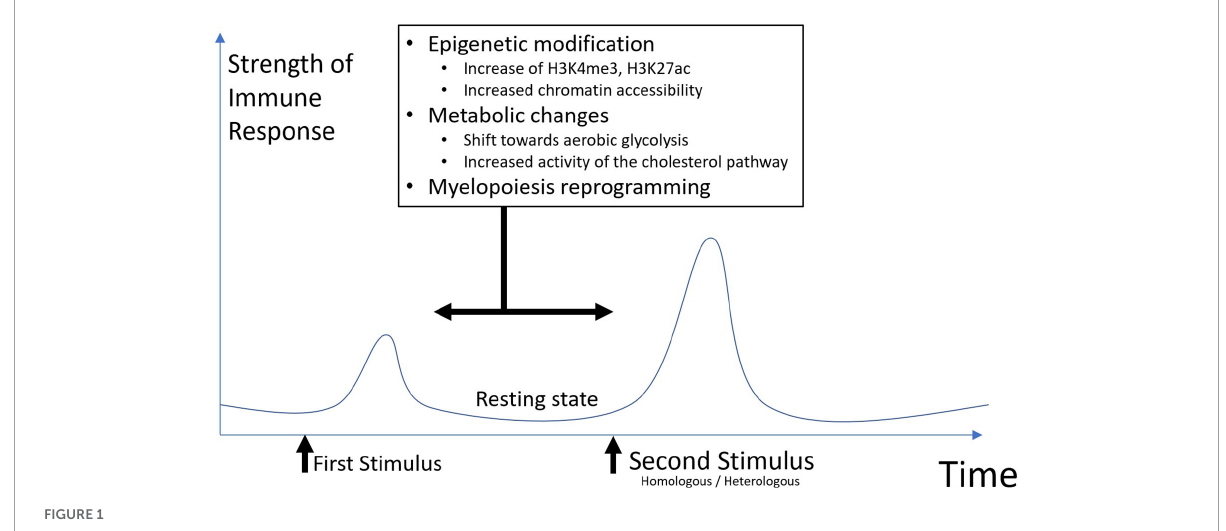
FIGURE1 Basic representation of trained immunity.